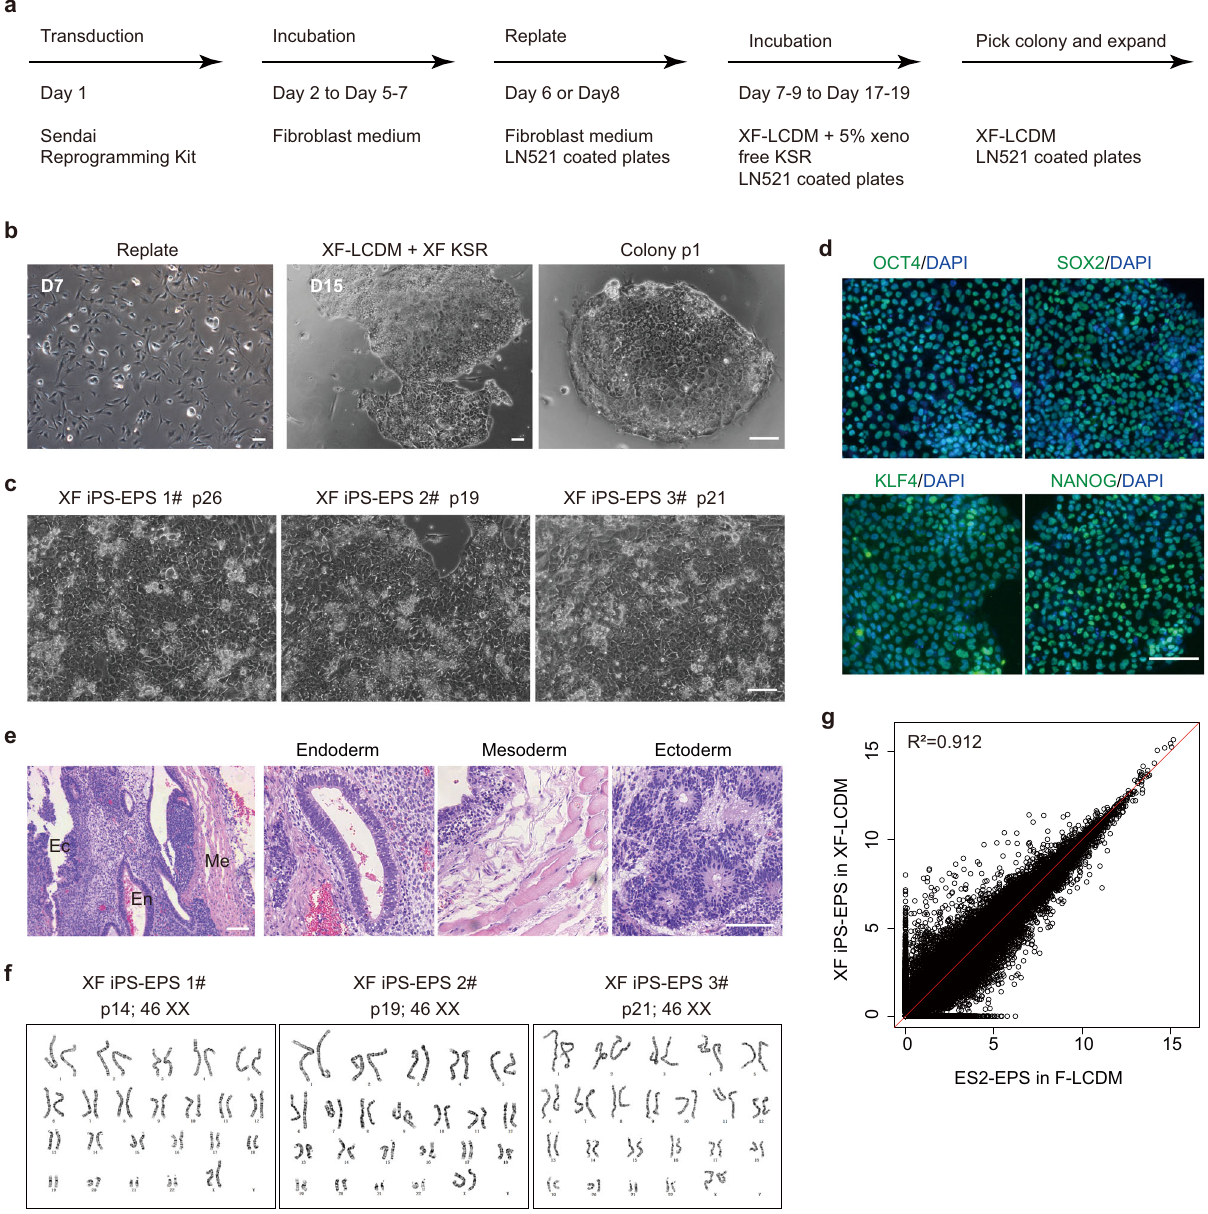
Fig. 5 The xeno-free LCDM condition supports hEPS cell generation from fi broblasts. a A diagram showing the procedures of generating xeno-free hEPS cells from human fi broblasts by reprogramming. b Representative images showing morphological changes of cells during reprogramming. Similar images were obtained in at least two independent experiments. c Representative images showing the morphologies of xeno-free human EPS cells derived from human fi broblasts. Similar images were obtained in at least two independent experiments. d Representative immunostaining images showing pluripotent marker gene expression in xeno-free hEPS cells derived from human fi broblasts. Similar images were obtained in at least three independent experiments. e Representative images showing histological analysis of teratomas generated from xeno-free hEPS cells derived from human fi broblasts. Similar images were obtained in at least three independent experiments. f Karyotype analysis of xeno-free hEPS cells derived from human fi broblasts. g Analysis of global gene expression correlation between feeder-cultured hEPS cells and xeno-free hEPS cells derived from human fi broblasts. F-LCDM, hEPS cells cultured on feeders; XF-LCDM, xeno-free hEPS cells. Scale bars, 100 µ m. Experiments in b – e were all independently repeated at least two times with similar dissected at the E6.5 or E10.5 developmental stage. Embryos, placentas and yolk sacs were isolated from conceptuses for further analysis. Animals . Animal experiments were performed according to the NIH guidelines. All of the mouse experiments performed in Deng laboratory were approved by the cell stage mouse embryos and ~15 injected embryos were transferred to each uterine horn of 0.5 or 2.5 day post-coitum pseudo-pregnant ICR females. Conceptuses were